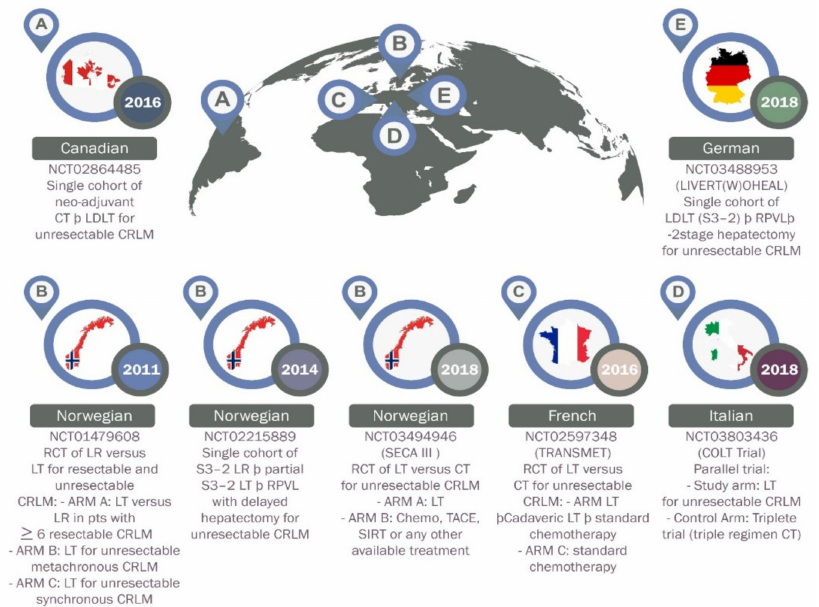
Figure 3. Current prospective trials on liver transplantation for colorectal liver metastases. NCT, National Clinical Trial; CT, chemotherapy; LDLT, living donor liver transplantation; CRLM, colorectal Liver Metastases; LT, liver transplantation; TACE, transarterial chemoembolization; S, stage; SIRT, selective Internal Radiation Therapy; RCT, randomized controlled trial; RPVL, right portal vein ligation; A-E, name of countries as flagged